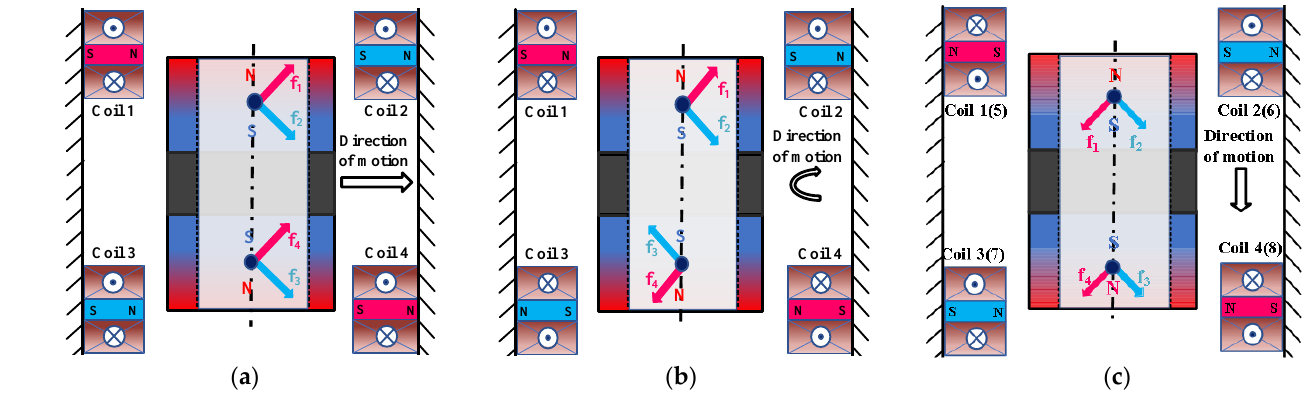
Figure 2. Principle of spindle motion control. ( a ) X direction; ( b ) Φ direction; ( c ) Z direction.